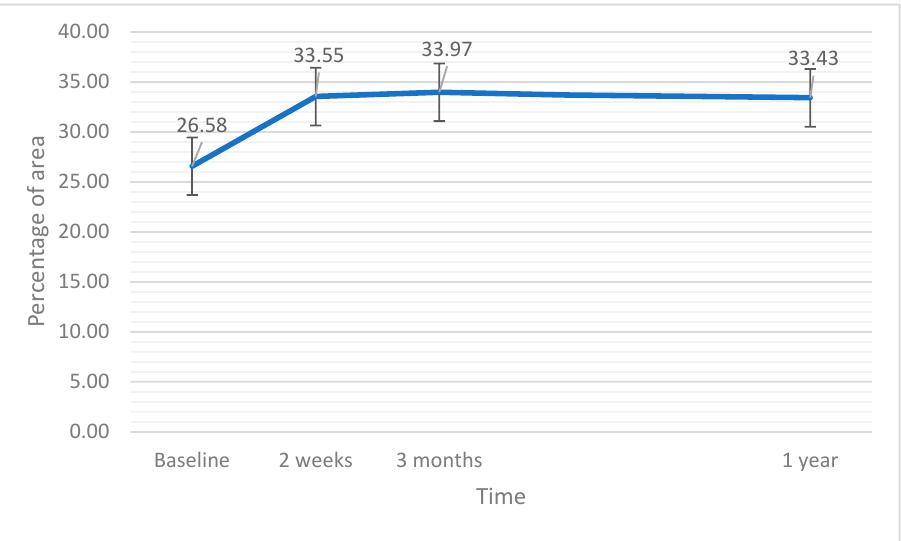
Figure 8. Vessel perfusion full (VPF) at baseline and after the surgery. The error bars represent 95% CI of the obtained results.